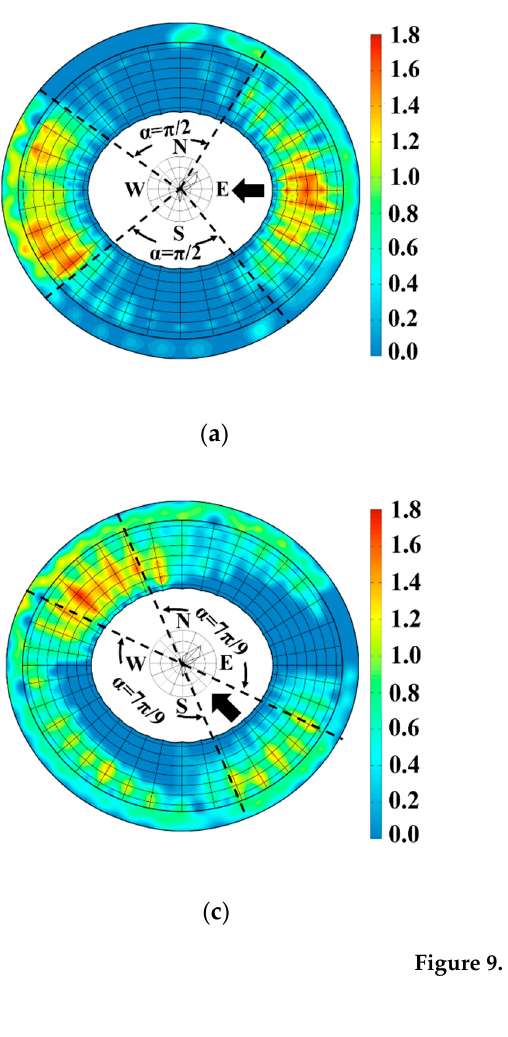
Figure 8. Study cases conducted for different inflow directions at 22.5° intervals (0°, 22.5°, 45°, 67.5°, and 90°).